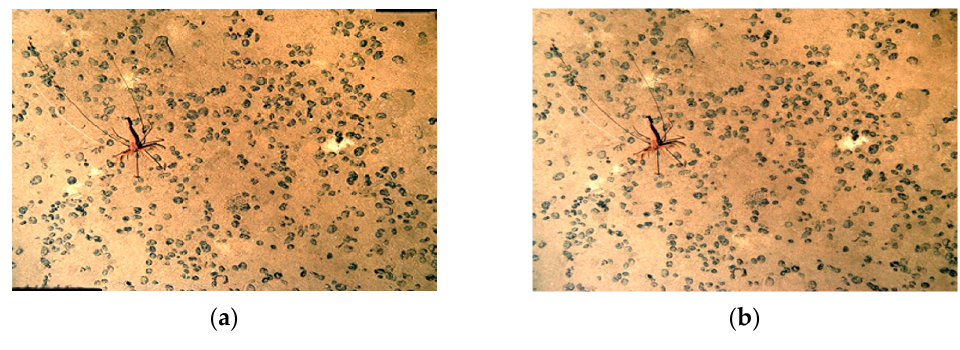
Figure 18. The fusion images for T4: ( a ) I-RANSAC; ( b )